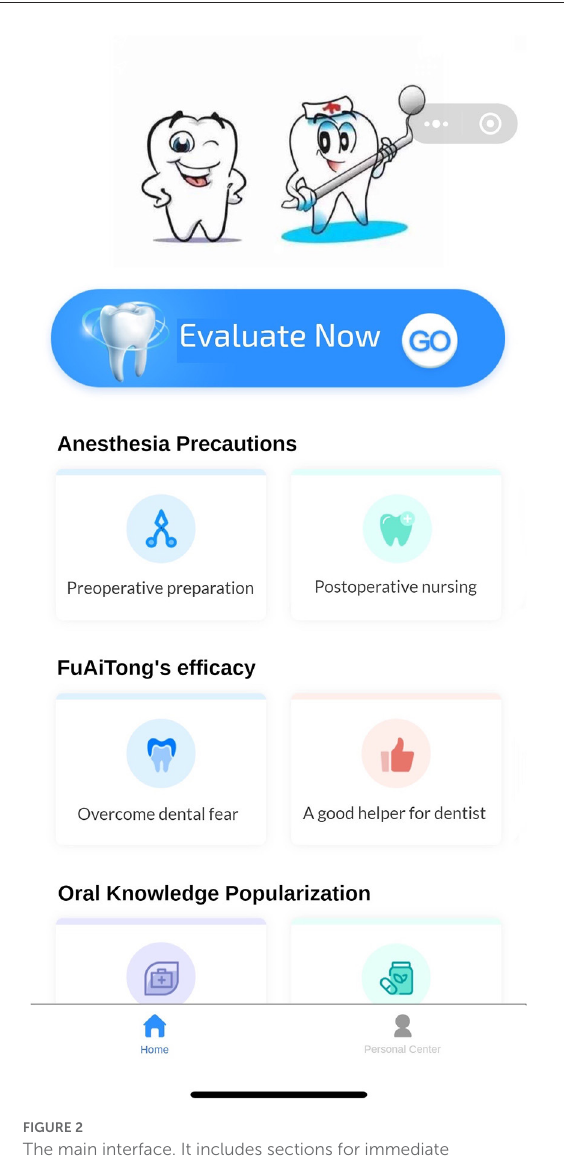
FIGURE2 The main interface. It includes sections for immediate pre-treatment assessment, anesthesia instructions, dental knowledge, and personal center. Users can choose according to their